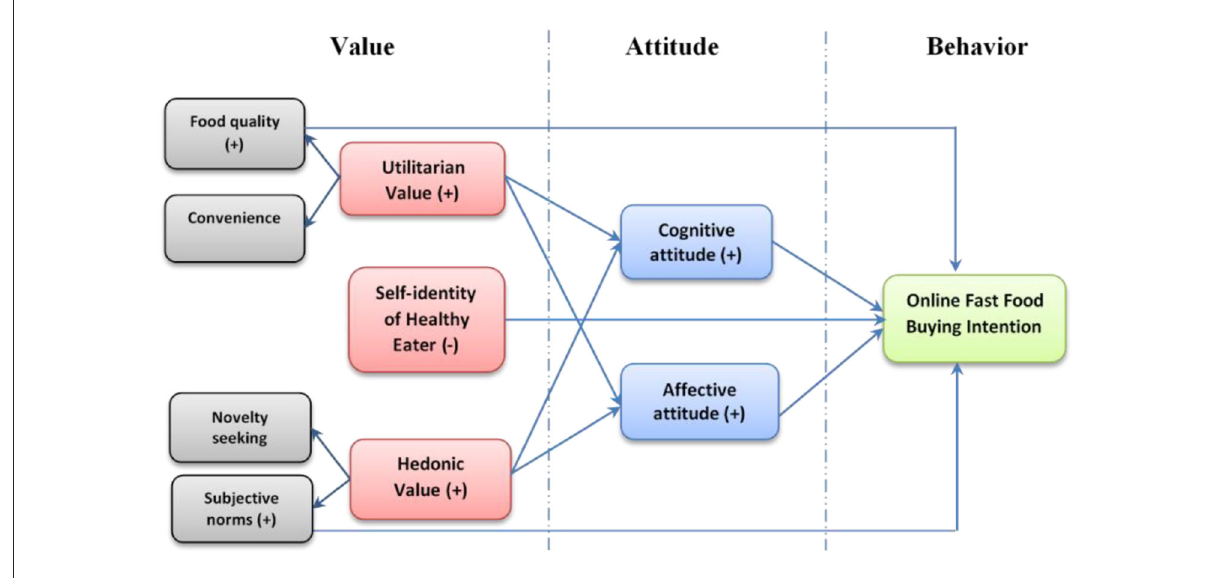
FIGURE1 Conceptual framework using VAB